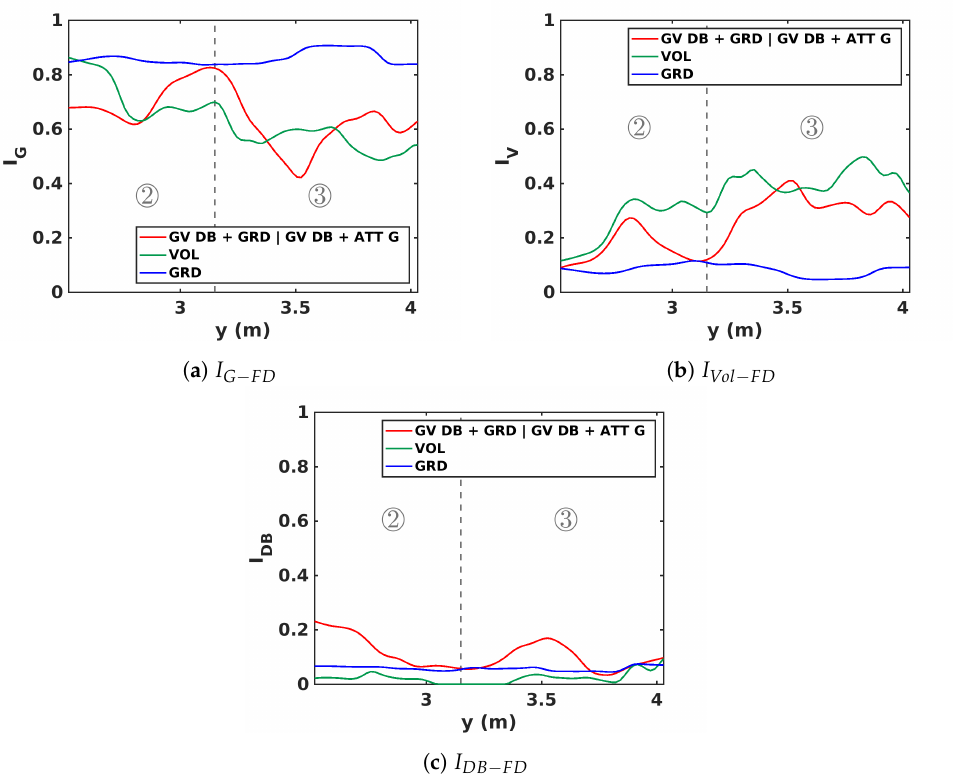
Figure 19. Freeman–Durden decomposition for identification of different scattering